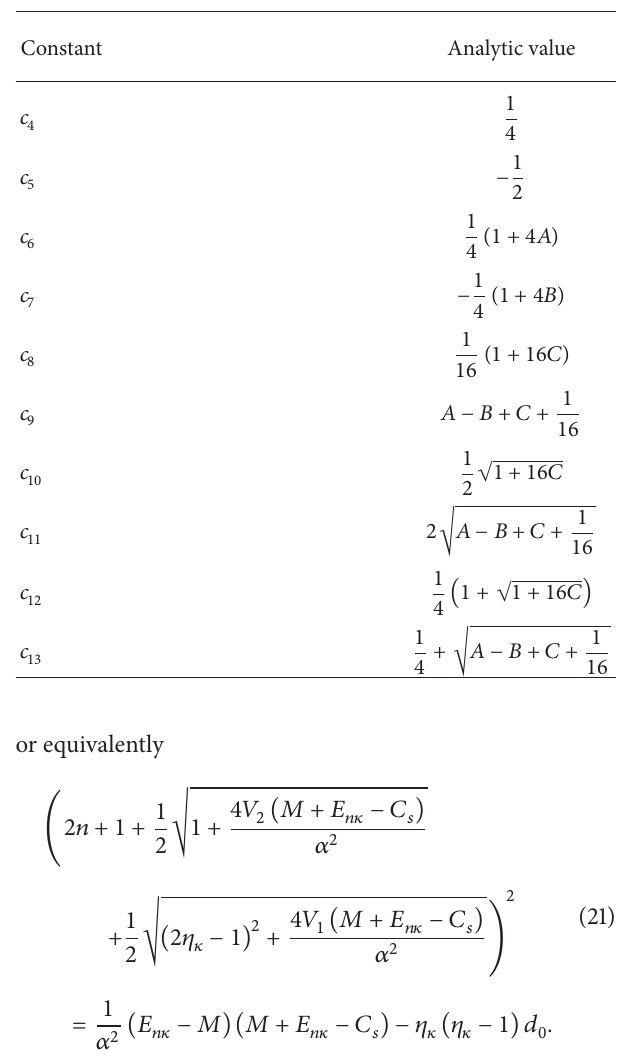
Table 1: The specific values of the parametric constants for the spin symmetric Dirac-tPT